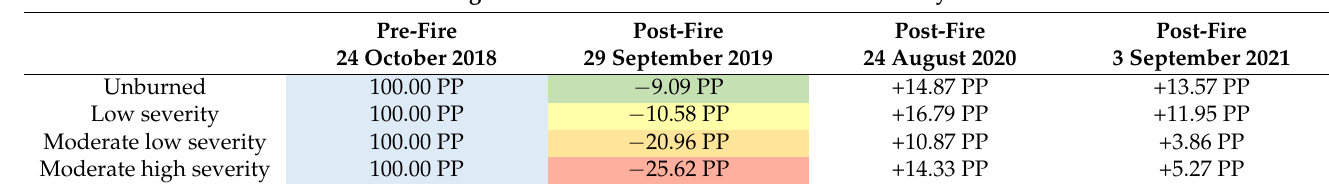
Table 7. Vegetation recovery according to the median LCCI per fire severity class compared to the pre-fire year in percentage points (PP) at the El Saco basin.